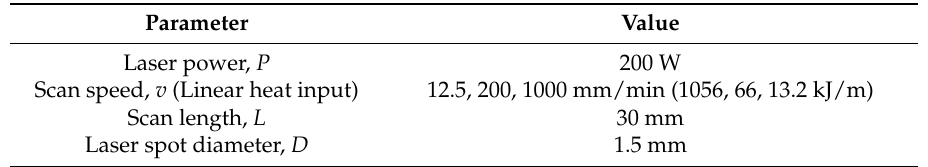
Table 4. Simulation